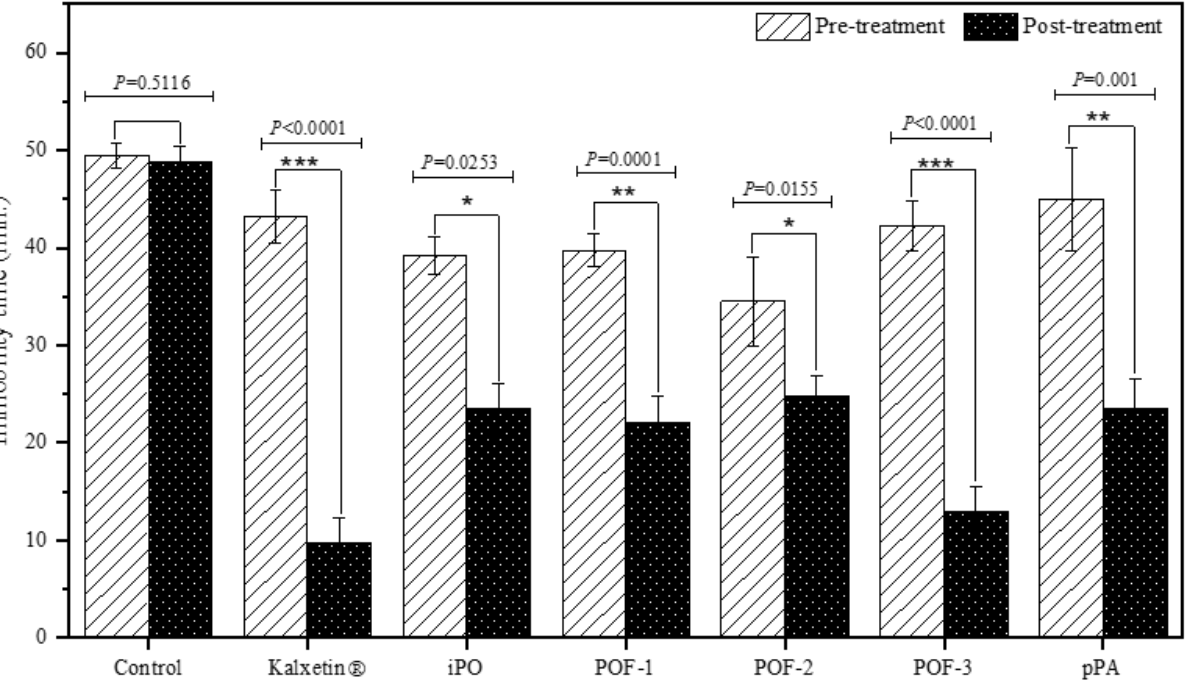
Figure 2. Rat’s immobility time observed during the TST, pre- and post-treatment. * significant at p < 0.05, ** significant at p < 0.01, and *** significant at p < 0.001 based on unpaired t -test with Welch’s correction.